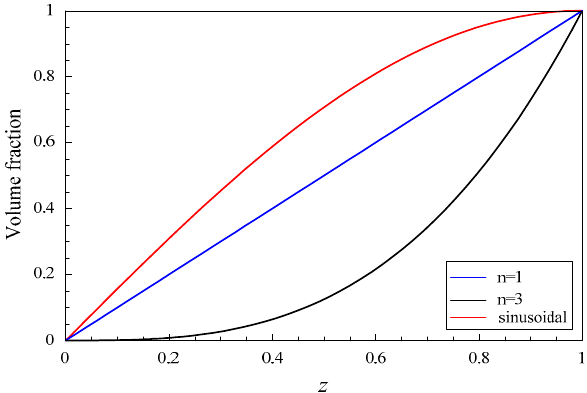
Figure 9. Variation curves of the three graded functions.